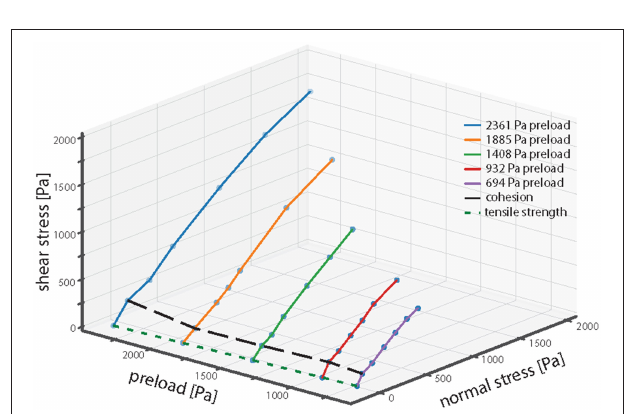
FIGURE 3 | Combination of material characteristics in a cam-clay type plot. Normal stress is plotted on the x-axis, shear stress along the y-axis. Along the z-axis, pre-loading is plotted. Stippled green line represents tensile strength, stippled black line is